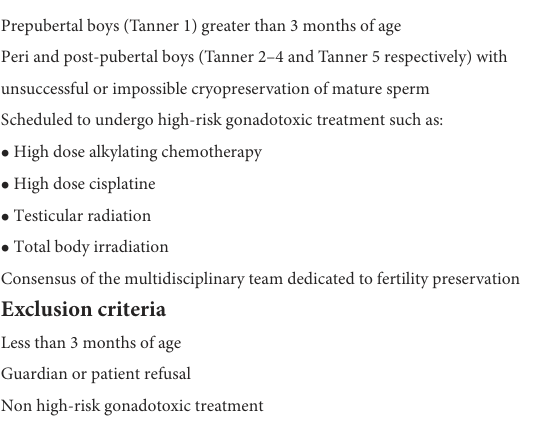
TABLE 1 Inclusion and exclusion criteria for testicular tissue